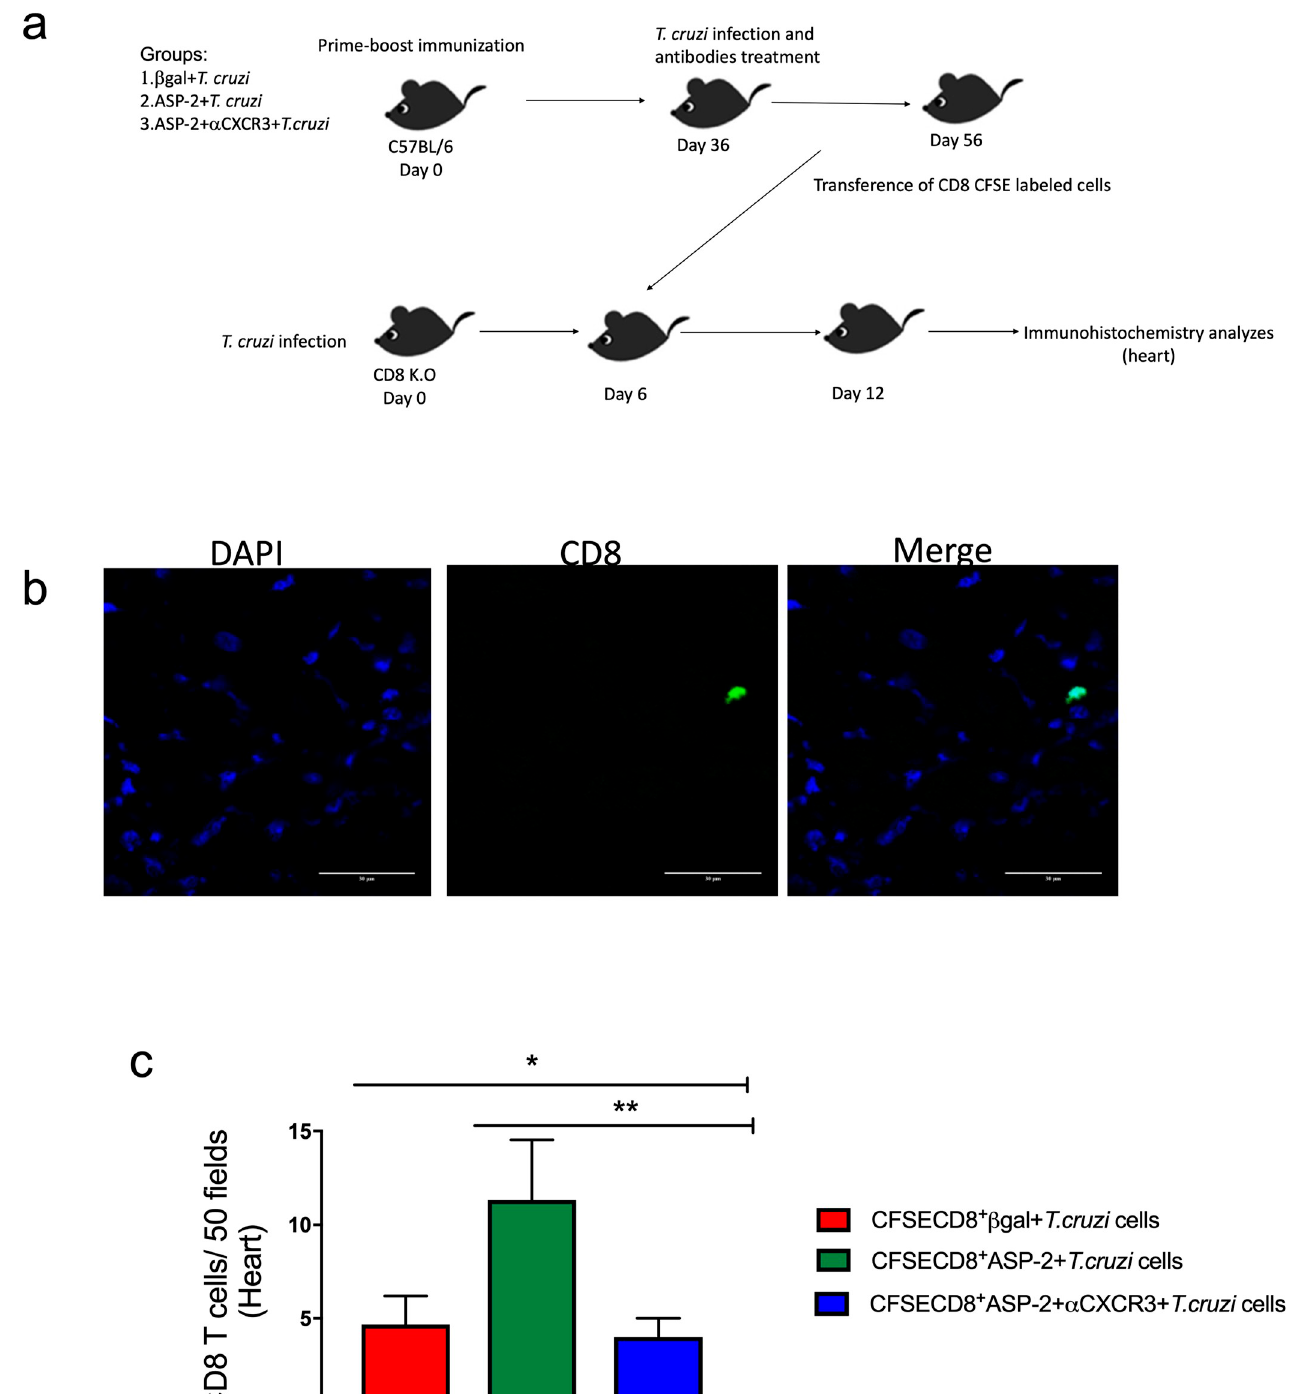
Fig 7. The treatment with anti-CXCR3 decreases the number of CD8 + T cells in the heart. a-Experimental design showing the immunization, infection, treatment with anti-CXCR3 antibody and adoptive transference of CD8 + CFSE labeled cells to CD8 deficient mice (infected). Briefly, C57BL/6 mice were immunized with prime-boost heterologous protocol, the first dose of immunization was with pCDNA3/pIgSPclone9 after 21 days of prime the mice received Ad β gal/AdSP-2 and after 15 days were infected with T . cruzi and treated with 250 μ g of CXCR3 antibody, and on day 20 after infection, CD8 + T cells from spleen were purified, labeled with CFSE, and transferred into CD8 K.O mice previously infected (on day 6 after infection). After 6 days of transference, the number of CD8 + T cells in heart from β gal+ T . cruzi ,ASP2+ T . cruzi and ASP2+ α CXCR3+ T . cruzi groups was quantified. b-IHC in heart showing the CFSE + CD8 + T cells (green). The DAPI staining was used to label the nucleus of the cells. c-Number CFSE + CD8 + T cells that migrated to CD8 K.O mice